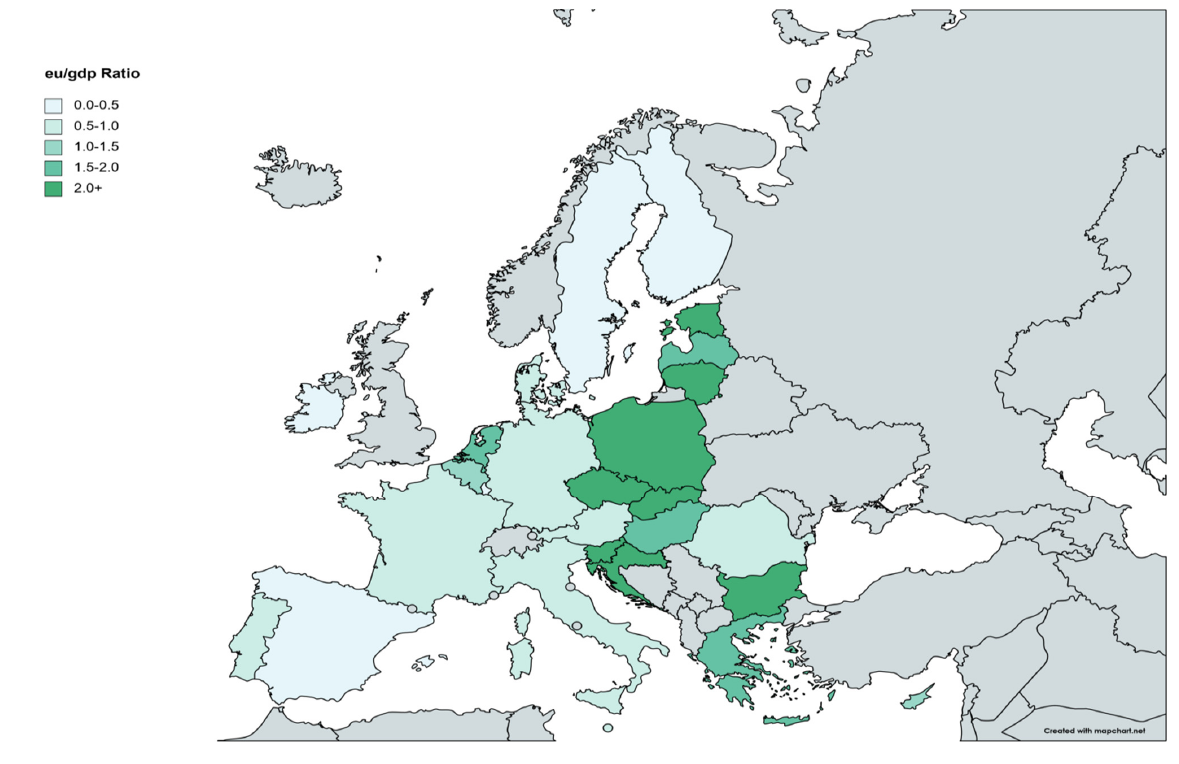
Figure 9. eu/gdp ratio by EU member State.